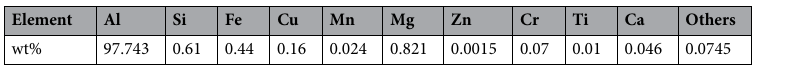
Table 3. Aluminium’s chemical composition.